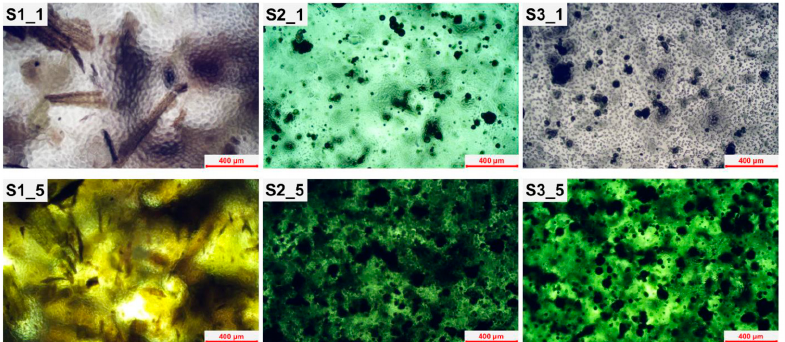
Figure 3. Optical micrograph of algae-thermoplastic polyurethane composites. S1 was fi lled with an Enteromorpha – Zostera marina blend, S2 with Chlorella vulgaris after oil extraction, and S3 with Chlo- rella vulgaris before oil extraction [57]. (Figures marked with 1 do represent samples with 1 wt.% algae, while those marked with 5 do represent samples with 5 wt.% algae) Distributed under the